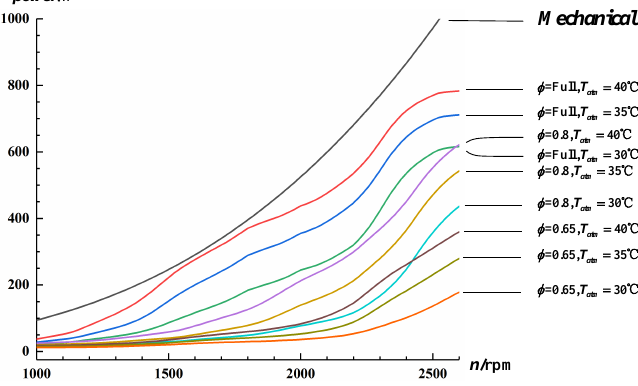
Figure 11. The total power consumption for several typical loads.